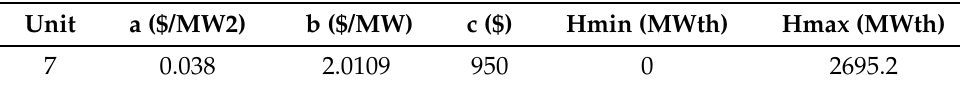
Table A9. Heat energy generator unit data for Case Study 3.